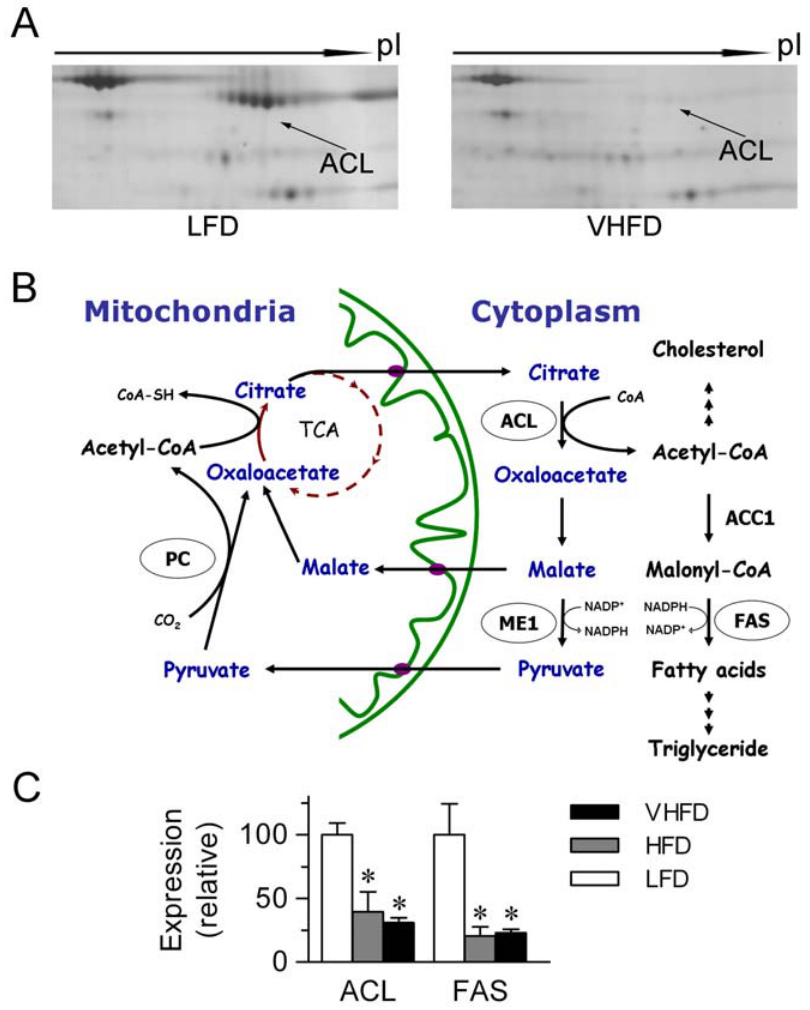
Figure 2. Identification by proteomic analysis of lipogenic enzymes suppressed in the white adipose tissue in response to the high- fat diet challenge. (A) Protein extracts of the epididymal fat pad from mice fed LFD vs. VHFD for 4 weeks (n=3/group) were fractionated by 2D SDS-PAGE. Proteins of interest were subsequently subjected to tryptic peptide identification analysis using LC-mass spectrometry. Shown is a representative section of the silver-stained 10% 2D SDS-PAGE gel with the migration of ACL protein indicated by the arrows. (B) Schematic diagram of the sequential steps in de novo lipogenesis as related to the TCA cycle in the mitochondrion. Highlighted by circles are the identified enzymes displaying predominantly decreased expression levels. (C) Real-time quantitative RT-PCR analysis of the mRNA expression levels of ACL and FAS in the WAT of mice fed LFD vs. VHFD for 4 weeks, shown as mean 6 SEM (n=3/group). * p , 0.05 vs. LFD-fed mice.